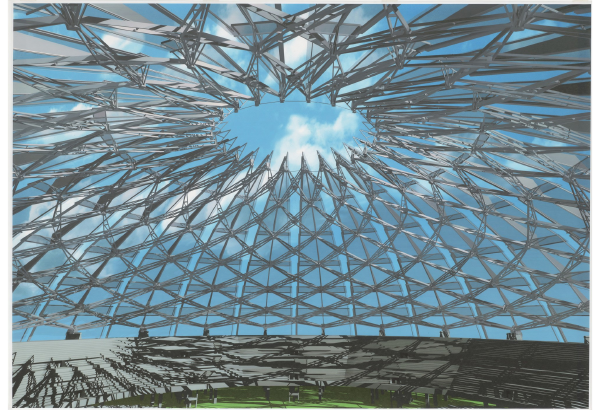
Figure 2: Chuck Hoberman, Iris Dome Project, Interior perspec-